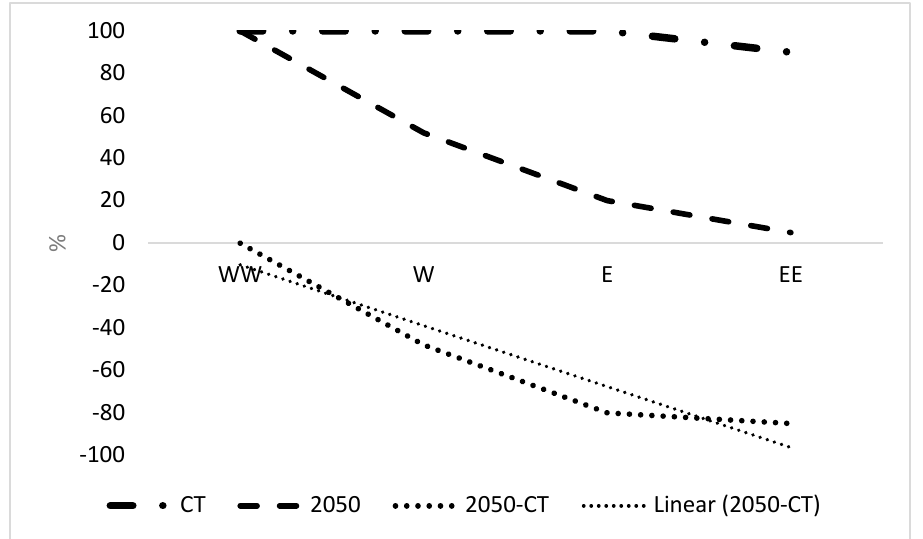
Figure 4. Longitudinal trends in CSC in the north zone of Nigeria. Direction abbreviations are WW, W, E and EE represent west-west, west, east and east-east, respectively. CT is current time. The east zone had the most significant decrease in CSC of the longitudinal zones